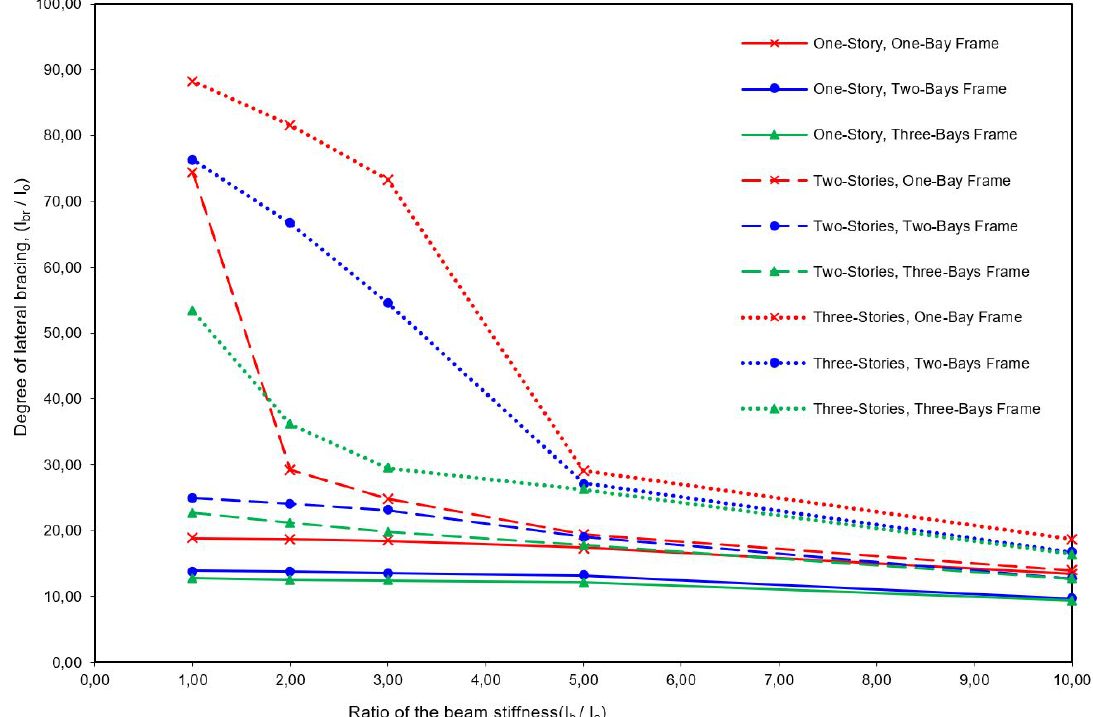
Figure 4. Relation between the ratio of the beam stiffness (I b / I o ) and the degree of lateral